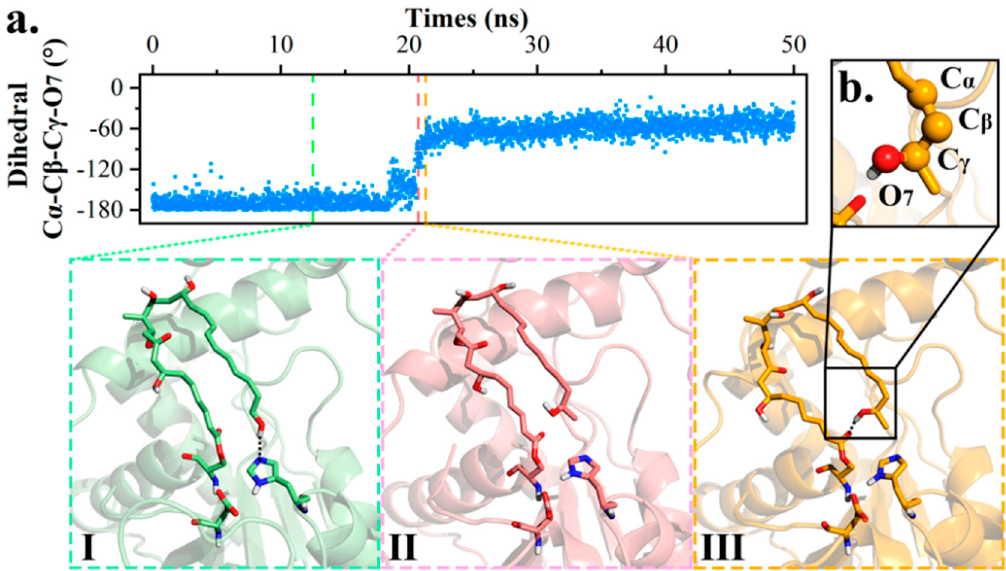
Figure 4. Conformational transformation between PRS and POS. ( a ) Dihedral value representation of md1 along with intermediate conformation change. ( b ) Presentation of dihedral angle C α -C β -C γ -O 7 .